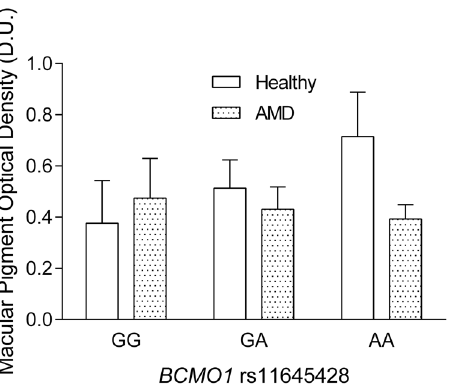
Figure 1. MPOD as a function of BCMO1 rs11645428 (error bars indicate + SD). Healthy participants with the GG genotype show on average significantly lower MPOD compared to those with the AA genotype. There were no significant differences between genotypes in the AMD group.